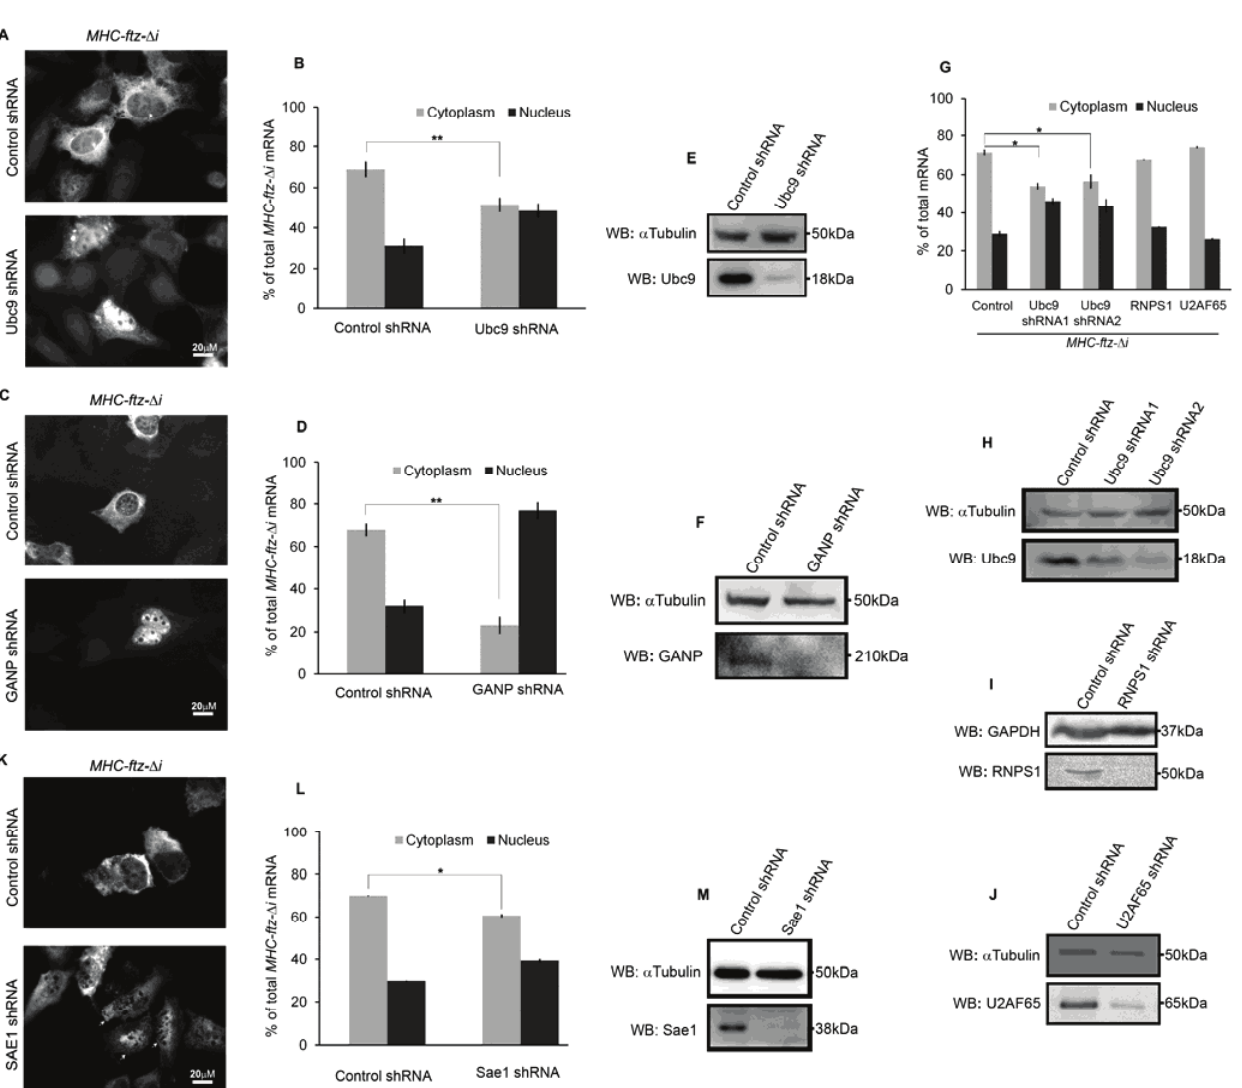
Figure 1. Ubc9, germinal center-associated nuclear protein (GANP) and Sae1 depletion alter the distribution of reporter mRNA MHC-ftz- (cid:2) i. U2OS cells were treated with lentiviruses which delivered plasmids containing control shRNA or pairs of shRNAs against Ubc9 ( A , B , E ), GANP ( C , D , F ), RNPS1 ( G , I ), U2AF65 ( G , J ) or Sae1 ( K – M ). Single shRNAs against Ubc9 were used in ( G , H ). Three (GANP) or four (Ubc9, RNPS1, U2AF65 and Sae1) days post-infection, cells were transfected with MHC-ftz- (cid:2) i reporter plasmid. The cells were then allowed to express the mRNA for 18–24 h. Transfected cells were then fixed and stained with a specific fluorescence in situ hybridization (FISH) probe against ftz sequence. Representative images ( A , C , K ) and the quantification summary of the cytoplasmic and nuclear integrated fluorescence intensity ( B , D , G , L ) of MHC-ftz- (cid:2) i mRNA are shown in control and depleted cells. Each bar indicates the average and standard error of three independent experiments in which each experiment consists of an average of at least 40–70 cells. * p < 0.05, ** p < 0.005. ( E , F , H – J , M ) Lysates of cells were probed with antibodies against Ubc9, GANP and Sae1. Immunoblotting against (cid:5)Tubulin or glyceraldehyde 3-phosphate dehydrogenase (GAPDH) was used as a loading